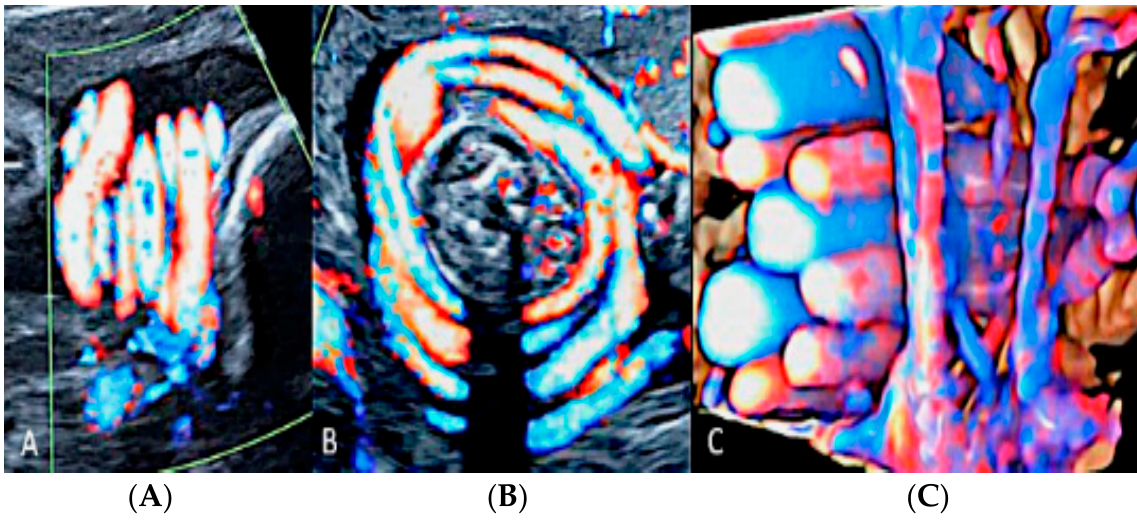
Figure 15. Two-dimensional ultrasound using color Doppler ultrasound and three-dimensional ultrasound with STIC color Doppler and “glass body” mode rendering with HD-Live™ flow showing multiple loops of cord around the neck in sagittal ( A ), axial ( B ) and coronal scans ( C ), resembling a “whirlpool” sign.